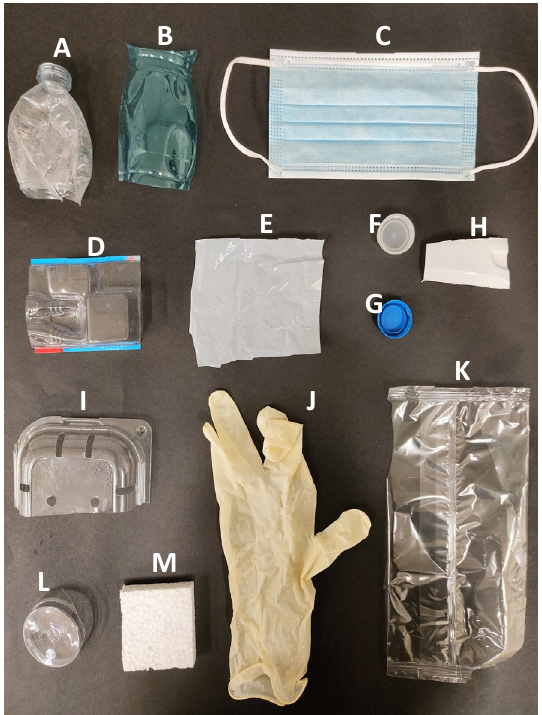
Figure 1. Picture of the used commercial plastic samples used in the fluorescence LIDAR experiment. The meaning of the labels ( A , B , C , D , E , F , G , H , I , J , K , L , M ) is detailed in Table 1.